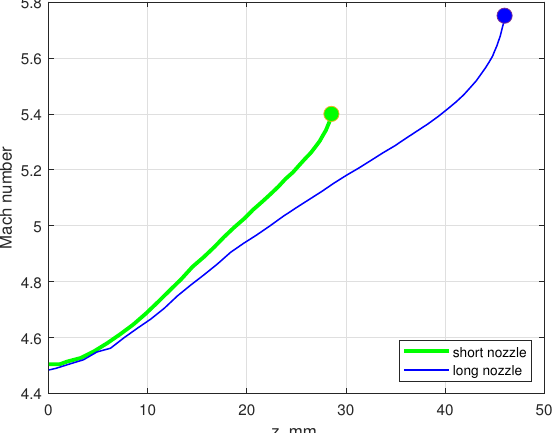
Figure 16. Calculated Mach number versus axial position along the nozzle extent. The M f for each nozzle case are marked as